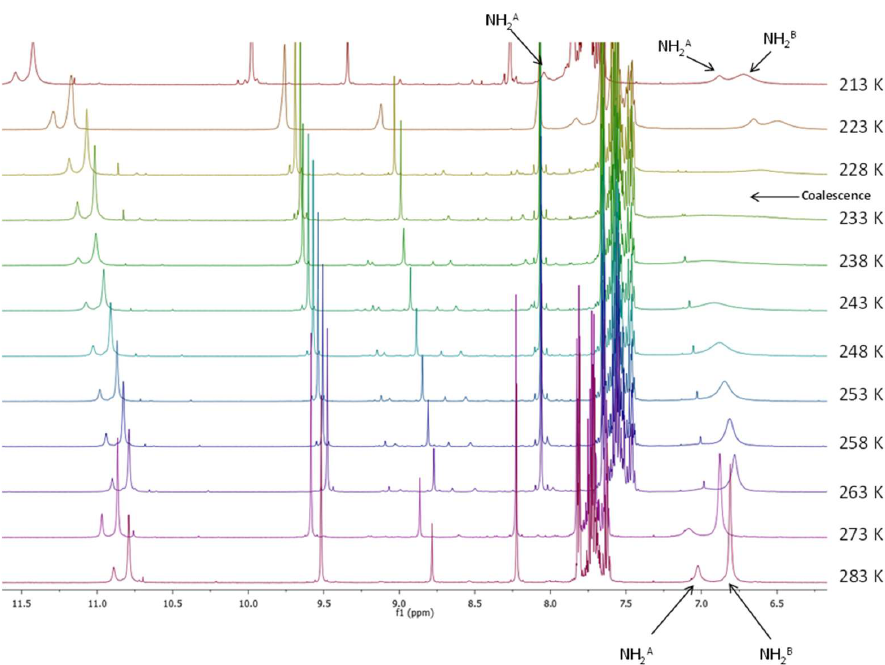
Figure 6. Proton dynamic NMR experiments of the carboxamidouracil isomers 8a and 8e in DMF- d 7 at low temperature. Different NMR spectra for amide 8 were recorded from 213–283 K, with 5–10 K intervals. Coalescence of the 6-amino group was detected between 228 K and 233 K.